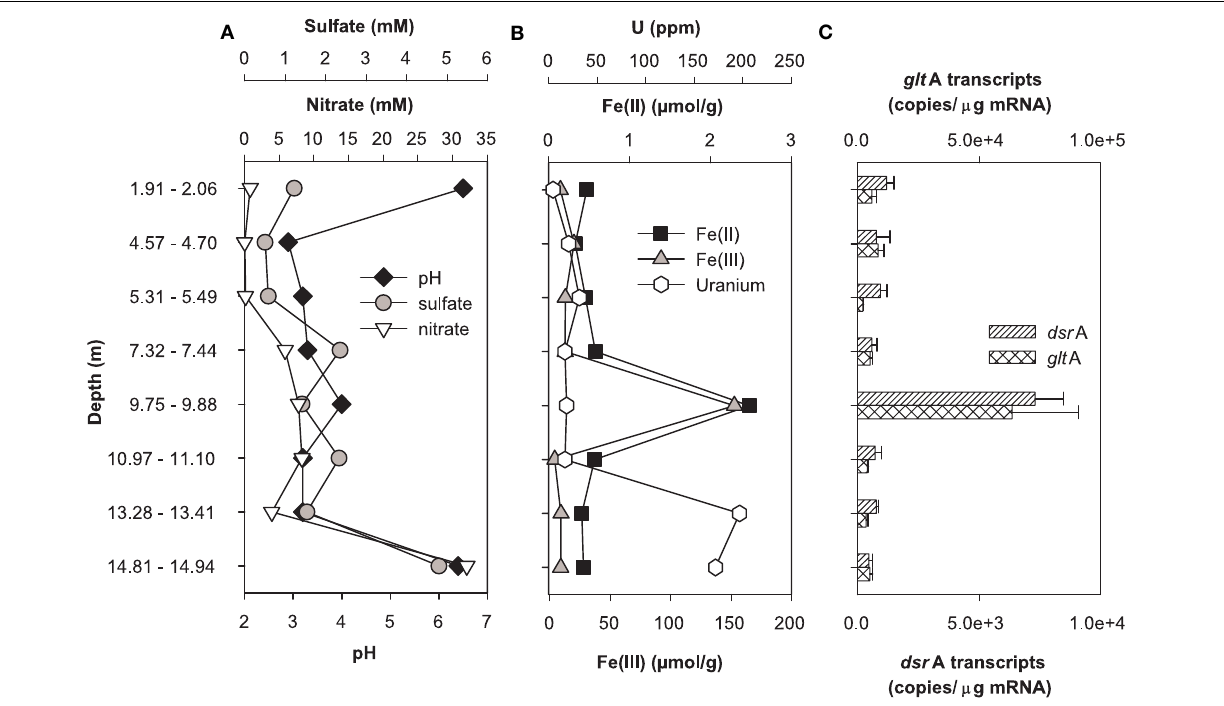
FIGURE 5 | Geochemistry (A,B) and levels of dsr A and glt A transcripts (C) in the depth interval from 5 to 7m ofArea 3 borehole FB124. Data for transcript levels are means ± standard deviations of triplicate determinations